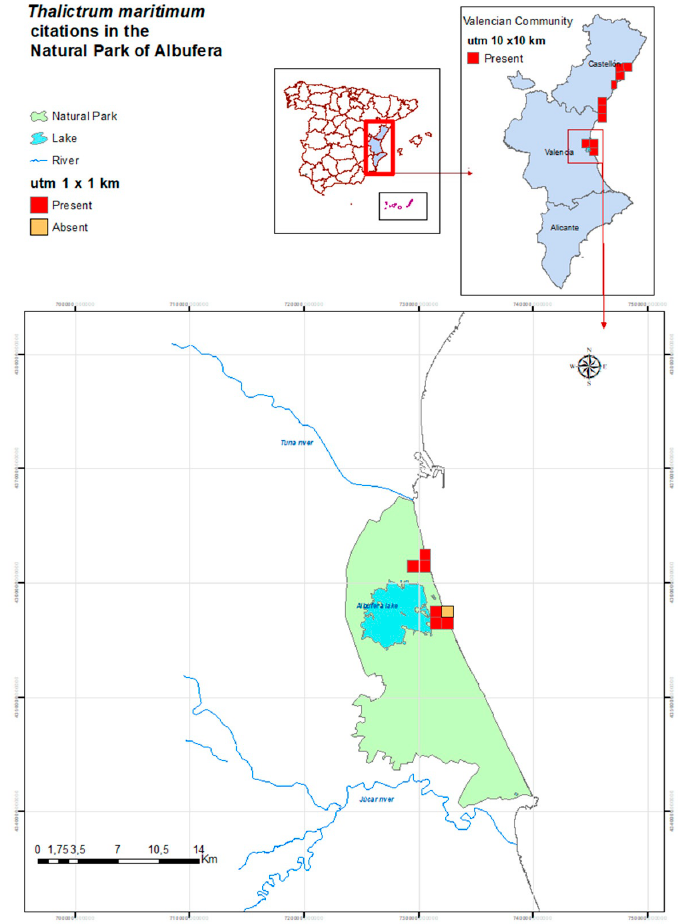
Figure 1. Location of the populations of Thalictrum maritimum in the Valencian Community (utm 10 × 10 km squares; upper right panel) and in the Natural Park of Albufera (utm 1 × 1 km squares; lower panel).